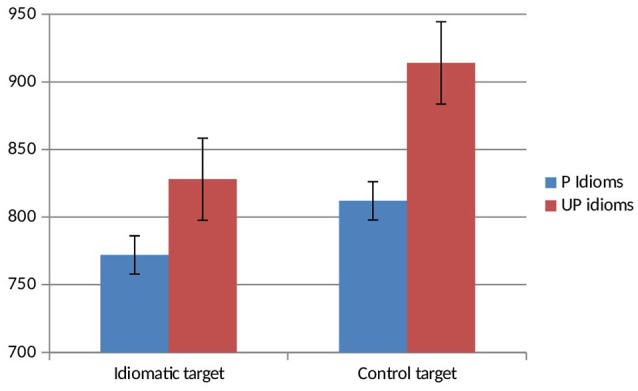
Means of the correct responses for idiomatic and control targets of predictable (P) and unpredictable idioms (UP idioms). Bars refer to standard error.